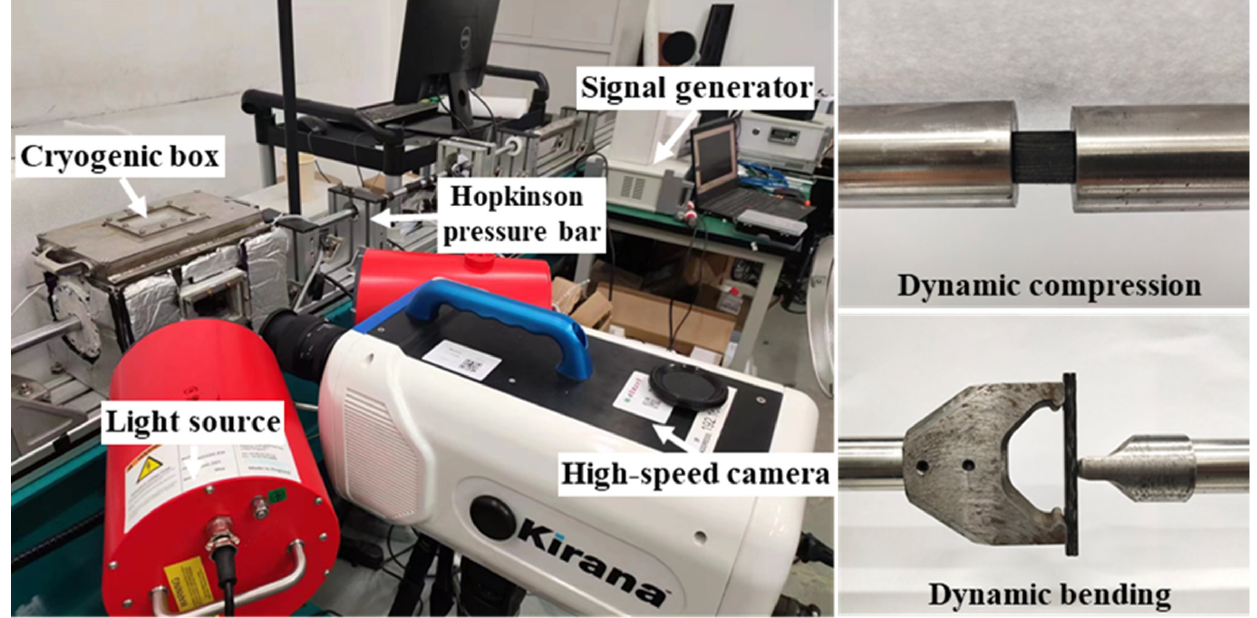
Figure 1. Ultra-low temperature dynamic experimental platform with synchronous observation function.